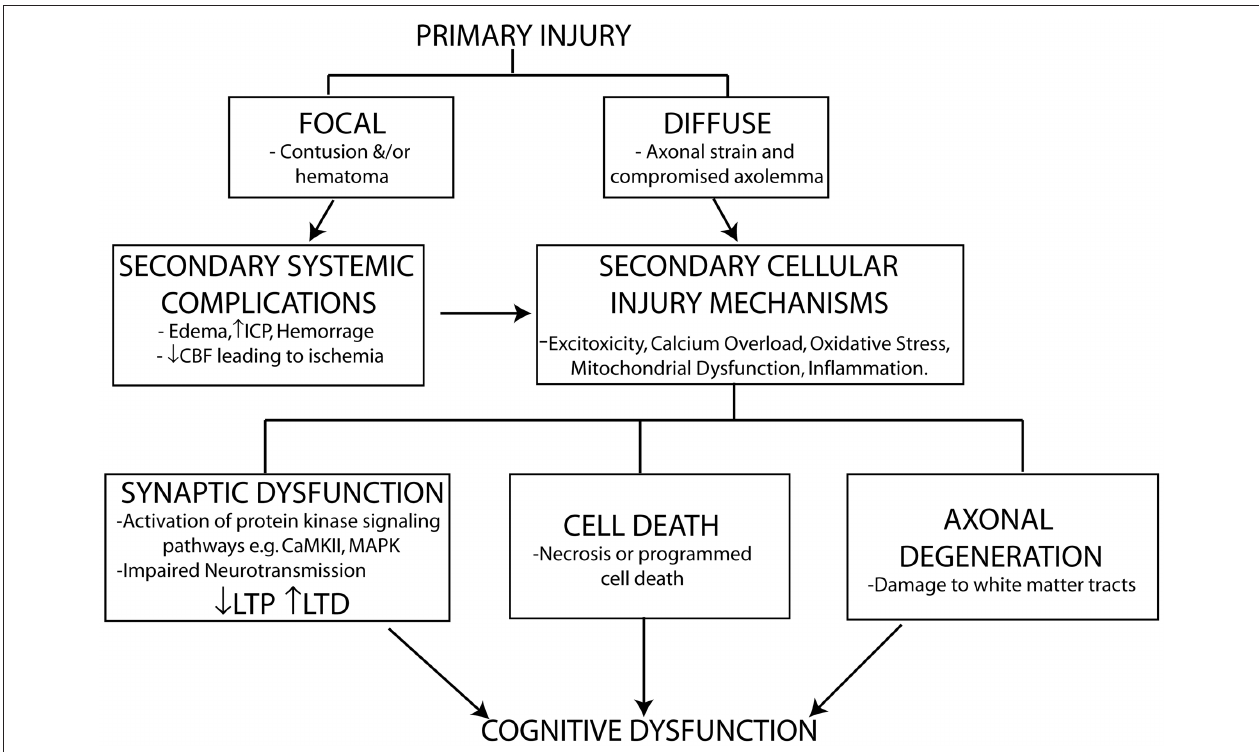
FIGURE 1 | Schematic representation of primary and secondary phases of injury leading to cognitive dysfunction following TBI. The primary injury force (direct physical impact or rotational accelaration/decelaration) gives rise to either a focal or diffuse injury which initiates secondary systemic complications and cellular injury mechanisms leading to cell death, axonal injury, and impaired synaptic plasticity contributing to the cognitive dysfunction observed following a